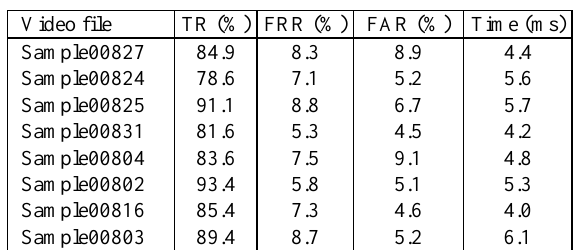
Table 3. Gesture recognition results and temporal estimators